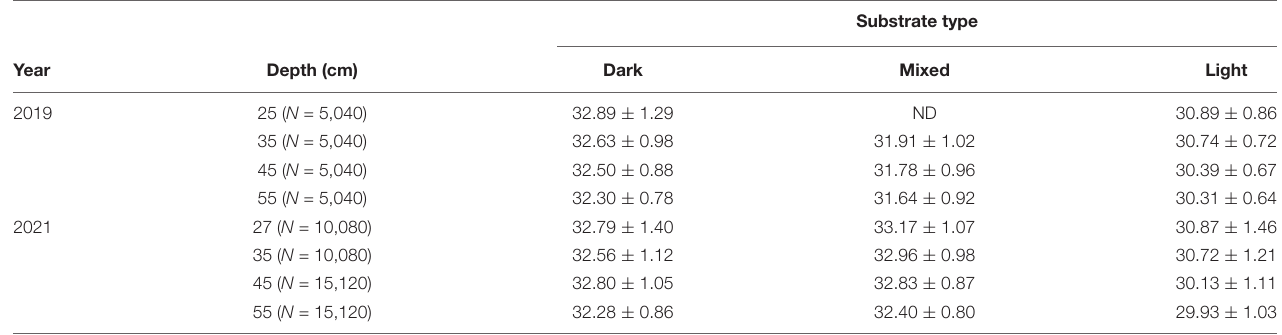
TABLE 3 | Temperatures recorded at four depths (25, 35, 45, and 55 cm) between August 05 and November 17 during two nesting seasons (2019 and 2021), under three different substrate types.